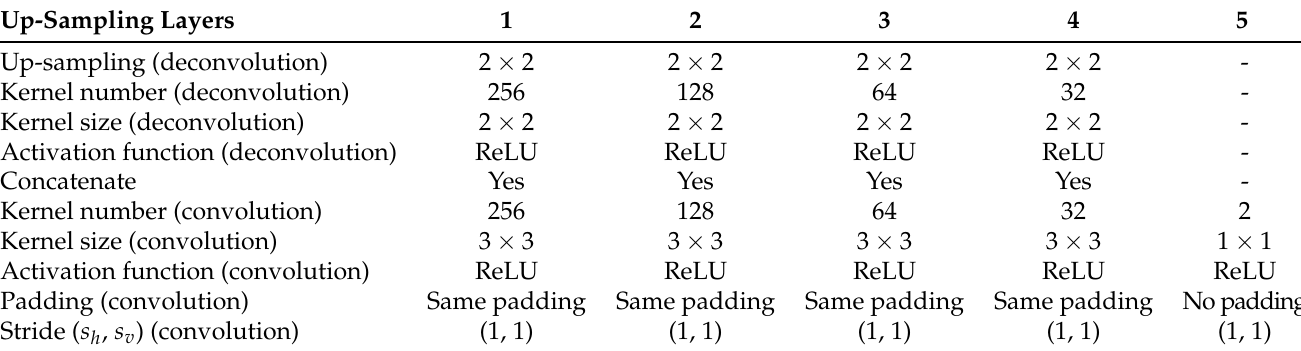
Table 2. Specifications of the up-sampling convolution